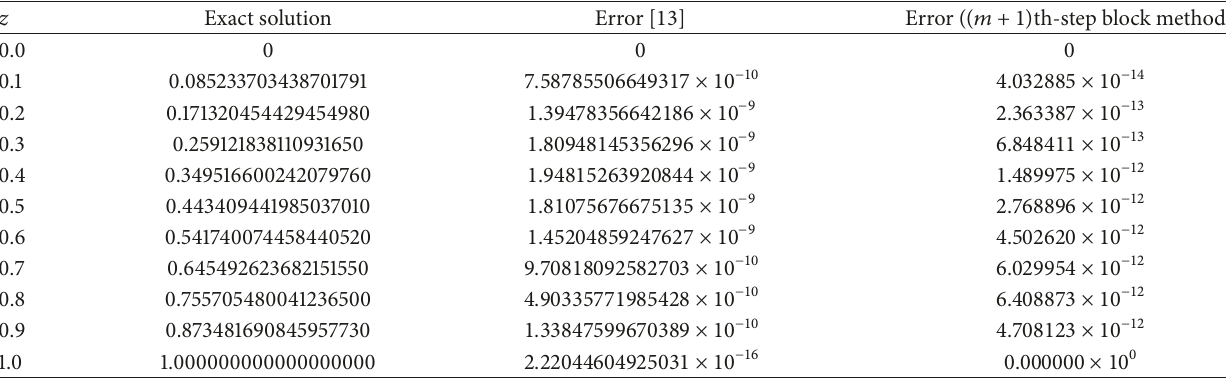
Table 3: Absolute errors of fifth-order HAM and (𝑚 + 1) th-step block method when 𝑅 𝑚𝑝 = 0